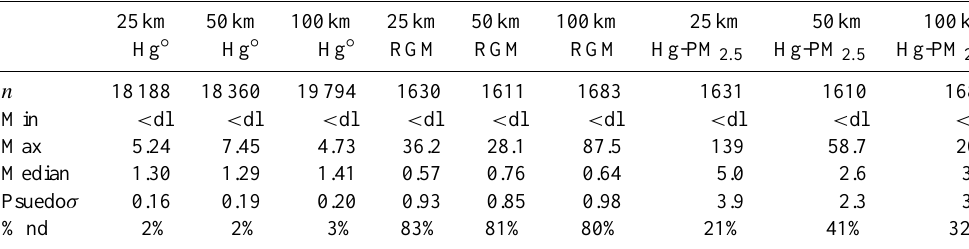
Table 1. Summary statistics of Hg species concentrations for fixed Tekran measurements at the 25km, 50km, and 100km sites. Median and psuedo σ (interquartile range/1.349) estimated using Kaplan-Meier survival curves for Hg ◦ data (values in ngm − 3 ) and regression on order statistics (ROS) for the other species (values in pgm − 3 ) , to account for measurements below method detection limits.